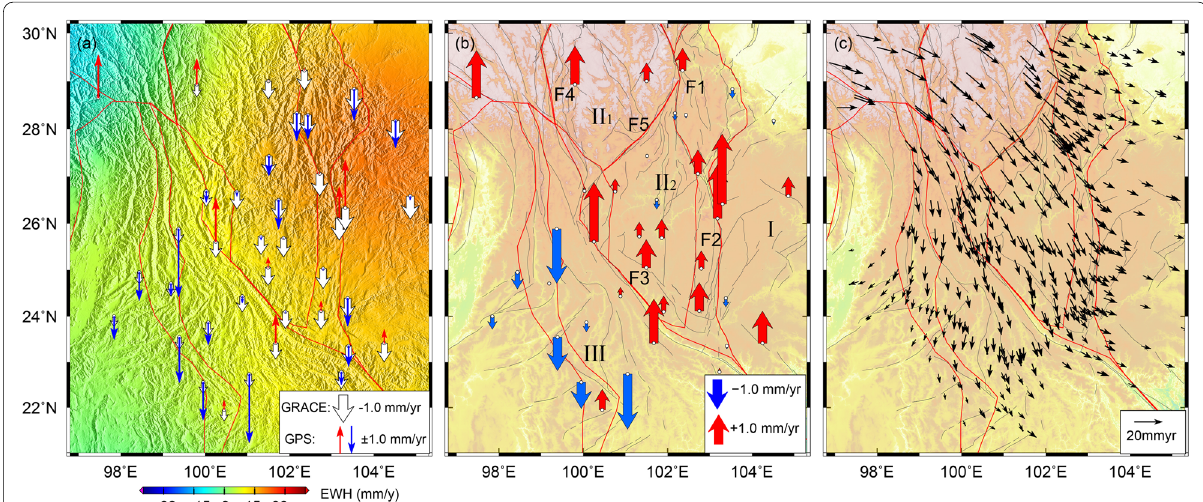
Fig. 9 Three-dimensional deformation in Southwest China. a Long-term surface mass variations (in equivalent water height, the background color), the linear vertical motion rate estimated by GRACE (white vector) and GPS (blue and red vector); red line represents the block boundary. b Vertical crustal motion rates by subtracting the rates of GRACE from the linear rates of GPS. F1: Anninghe fault; F2: Xiaojiang fault; F3: Red river fault; F4: Jinshajiang fault; F5: Xiaojinhe fault. I: South China block; II: Sichuan–Yunnan rhombic block; II 1 : West Sichuan block; II 2 : Central Yunnan block; III: Southwest Yunnan block. c Horizontal velocity field provided by Wang and Shen